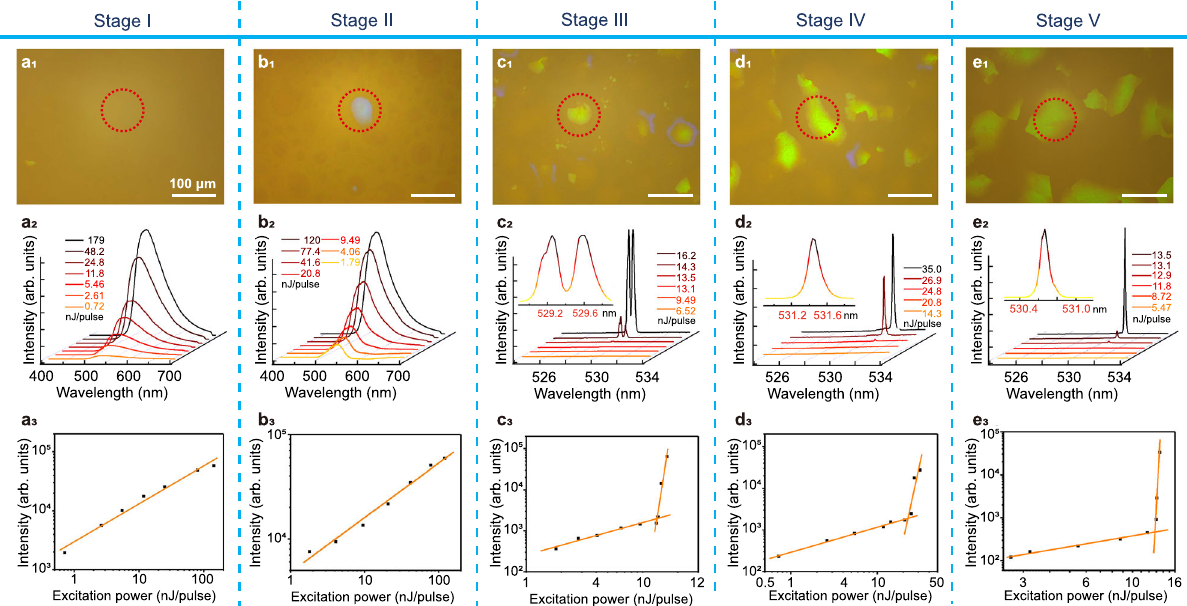
Fig. 7 Band-edge lasing of BPI in each phase-transition stage. a 1 – e 1 Platelet textures of dye-doped PS-BPLCs captured using an inverted optical microscope in re fl ection mode; red dotted circles mark the greenish lasing phase platelets. a 2 – e 2 Emission spectra plotted relative to the low-energy photonic band-edge. The insets show magni fi ed images of the lasing peaks. The measured FWHMs of the lasing peaks vary from 0.579 to 0.105 nm. a 3 – e 3 Best fi ts of typical input-output curves for the data below and above the excitation threshold. Lasing is realized in a relatively small BPI domain (~60 μ m) based on the high degree of order of BCC structures. The gradual narrowing of the lasing peaks from Stages III to V suggests an improvement in the lattice order of (Fig. 6e). The texture distribution and the corresponding QR codes (Fig. 6e) are distinct from those of the fi rst cooling process